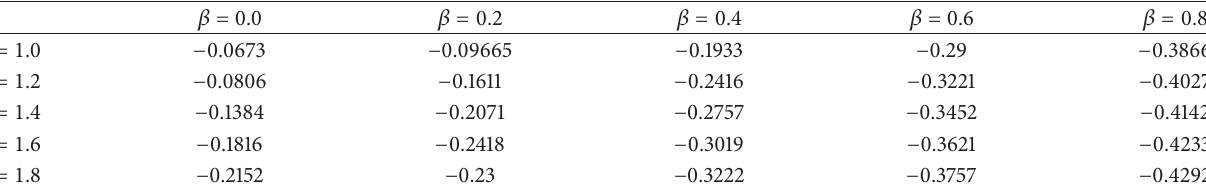
Table 3: Decision bias of (𝜇 ∗